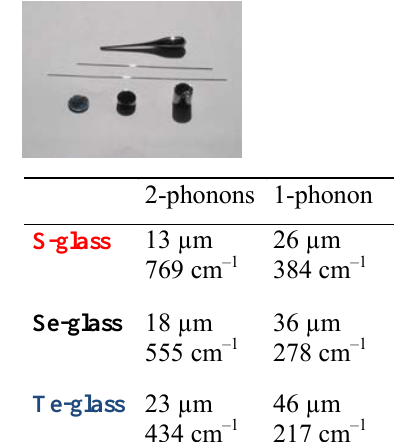
Figure 8. Transmission of tellurium glass (TGG) compared to selenide and sulfide equivalent glasses. They transmit the light over a wide range of wavelength until 25 µm depending on the thickness of the sample. TGI glasses exhibit an equivalent optical transmission and are easier to shape into optical fibers. More generally, The IR cut off is due to the multi phonon absorptions related to the relative weight of S, Se and Te